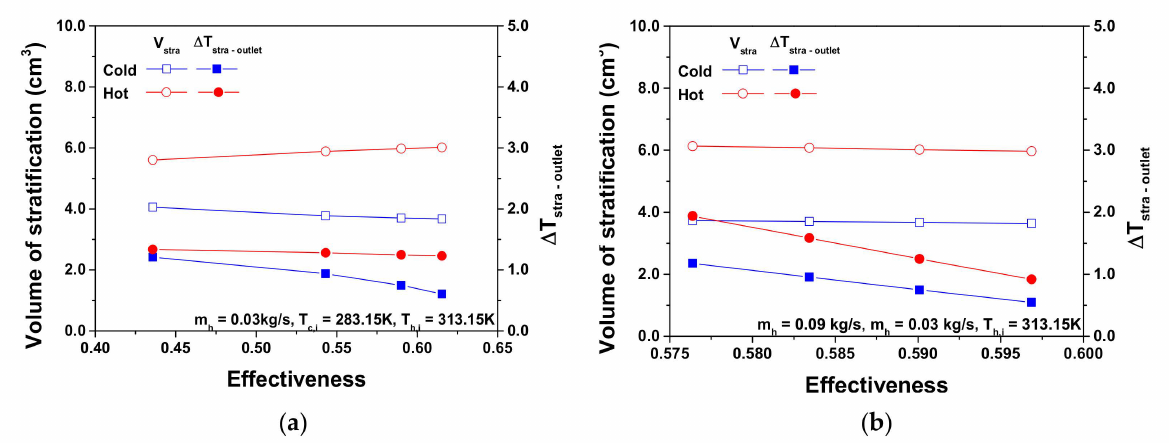
Figure 9. The volume of stratification and ∆ T_(stra-outlet): ( a ) according to the mass flow rate of the cold side, ( b ) according to the inlet temperature of the cold side.